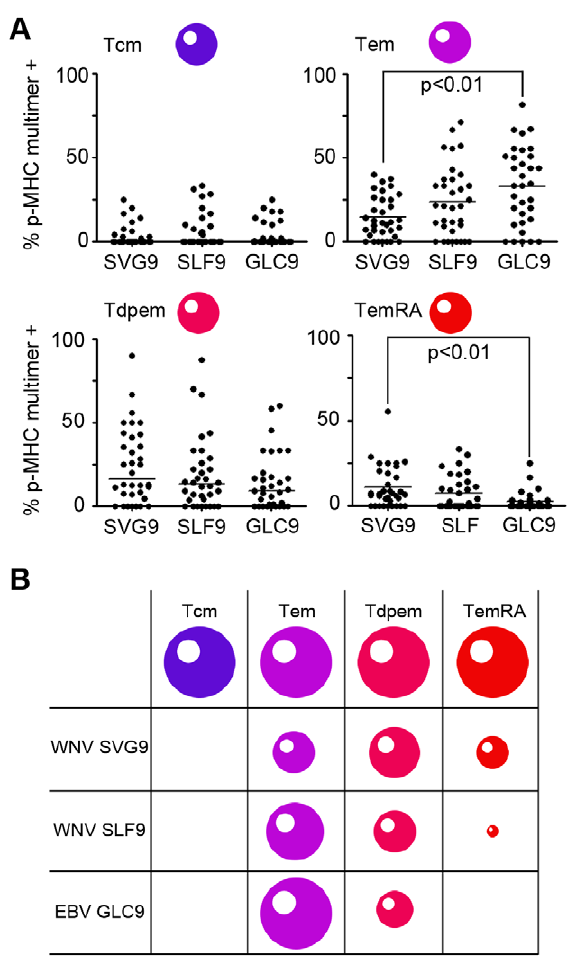
Figure 3. The phenotype of WNV SGV9 and SLF9 specific cells differs from that of EBV specific cells. (A) Prevalent memory phenotypes of antigen experienced T cells are shown, based on expression of CD27, CD45RA, CCR7, CD57 as defined in Table 2. For data that did not fit a normal distribution a Kruskal-Wallis ANOVA was used with Dunn’s method of comparative analysis and medians are shown. In all other cases a one way ANOVA with a Tukey post-hoc test was used and means are shown. (B) The size of each cell represents the median percentage of the prevalent memory phenotypes for each of the epitopes examined in